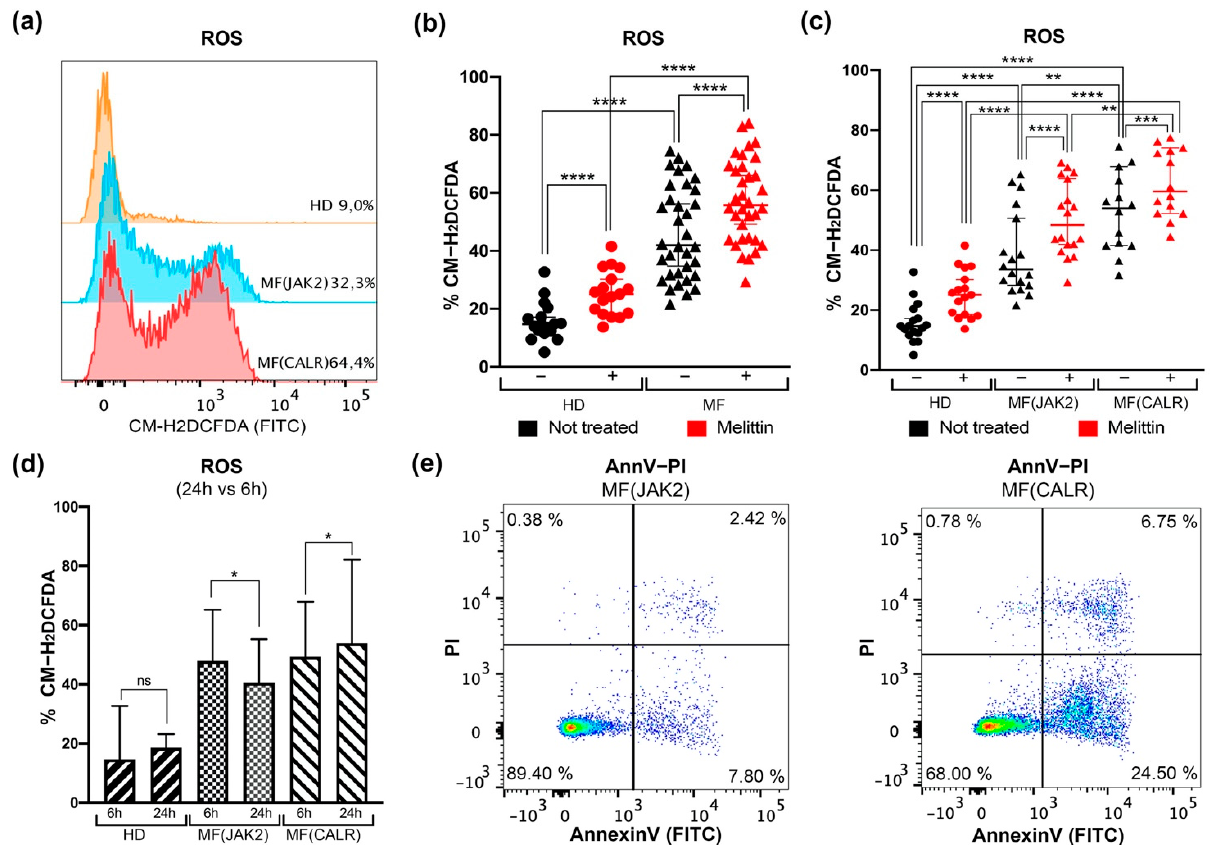
Figure 1. Detection of intracellular ROS levels in CD34+ cells of MF patients. ( a ) Representative histograms for flow cytometry detection of CM-H2DCFDA staining at 6 h in untreated CD34+ cells of HD, MF( JAK2 ) and MF( CALR ) samples. ( b ) Dot plot shows the percentages of intracellular ROS assessed in HD and in MF samples, with (red dots) or without (black dots) 6 h of Melittin treatment respectively. The comparison between HD and MF was analyzed using Mann–Whitney U test, while the comparisons between treated and untreated cells were analyzed with Wilcoxon matched-pairs signed rank test. ( c ) Dot plot shows the percentages of intracellular ROS in the comparison between JAK2- or CALR -mutated MF patients compared to HD, with (red dots) or without (black dots) 6 h Melittin treatment respectively. The comparisons between HD and MF( JAK2 ) and between HD and MF(CALR) was analyzed with Mann–Whitney U test, while the comparisons between treated and not treated cells were analyzed with Wilcoxon matched-pairs signed rank test. ( d ) Histogram shows the percentages of intracellular ROS after 6 and 24 h; the statistical test used was Wilcoxon matched-pairs signed rank test. ( e ) Representative dot plots for flow cytometry detection of Annexin V/PI staining in CD34+ cells of MF( JAK2 ) and MF( CALR ) samples. Data are reported as median with 95% CI (confidence interval). * p < 0.05, ** p < 0.01, *** p < 0.001, **** p < 0.0001.